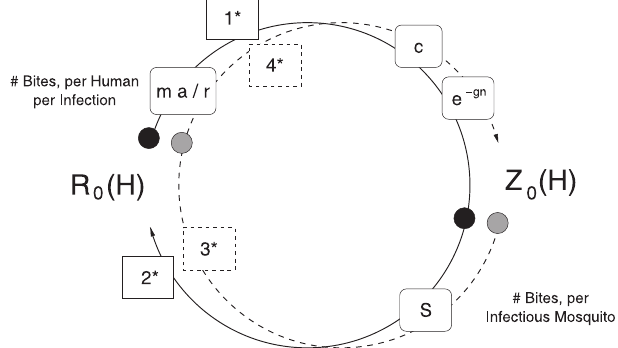
Figure 4. R 0 , R 0 ( H ), and Z 0 ( H ) in Finite Populations In finite populations, the number of different hosts infected through one complete generation of the parasite differs when the counting starts with humans, R 0 ( H ) (black circles, solid line), or with mosquitoes, Z 0 ( H ) (grey circles, dashed line), because of the different proportion of